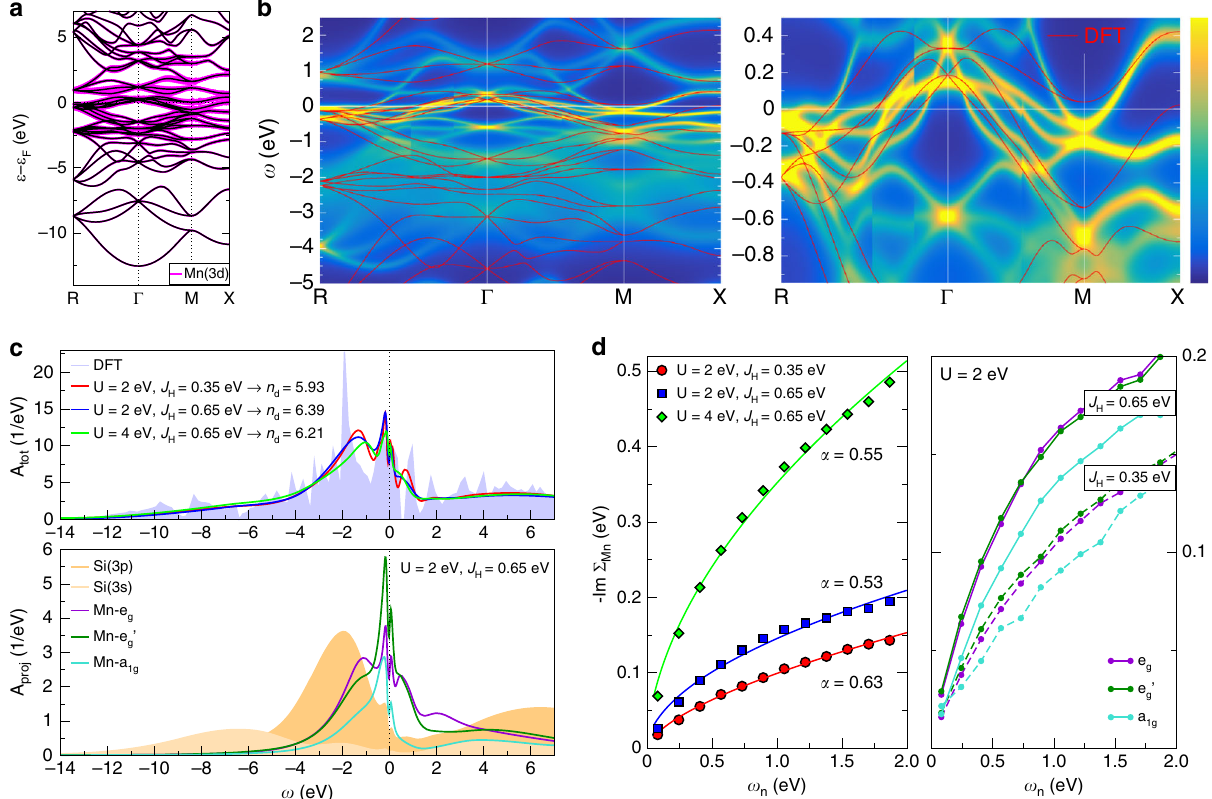
Fig. 3 One-particle properties of the MnSi correlated electronic structure. a Band structure from nonmagnetic DFT. Purple color marks the Mn(3 d ) character. b DFT + DMFT k -resolved spectral function in paramagnetic phase for U = 2 eV, J H = 0.65 eV in smaller window (left) and close to the Fermi level (right). High spectral density is noted as yellow in the color bar and low density as dark blue. The nonmagnetic DFT bands are overlayed (red lines). c k -integrated spectral function for different interaction strengths. Top: total spectrum with respective Mn(3 d ) occupation n d , Bottom: orbital-resolved projection onto the Mn(3 d ) states and the Si states. d Imaginary part of the Mn self-energy for different interaction strengths at small Matsubara frequencies ω n = (2 n + 1) π T . Left: orbital-averaged – Im Σ Mn (i ω n ) (symbols) with fi tting function F ( ω n ) = K ω n α (lines). Right: orbital-resolved self-energies for U = 2 eV and J H = 0.35, 0.65eV.